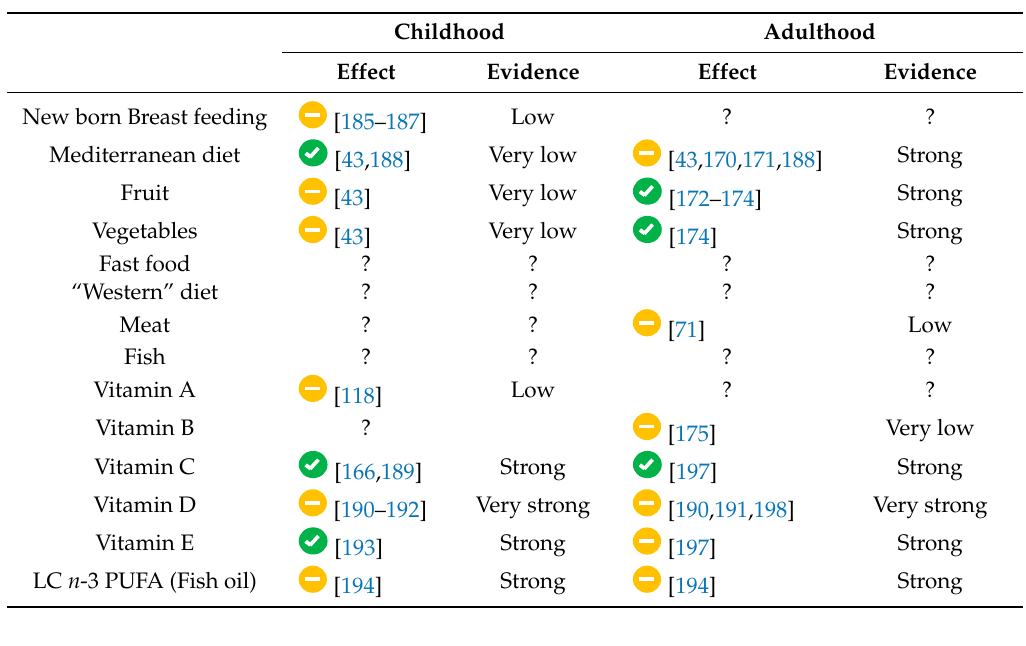
Table 3. Diet and lung function in asthma patients. Table 1. Diet and risk of asthma or wheezing. Beneficial effect; Table 1. Diet and risk of asthma or wheezing. Beneficial effect;